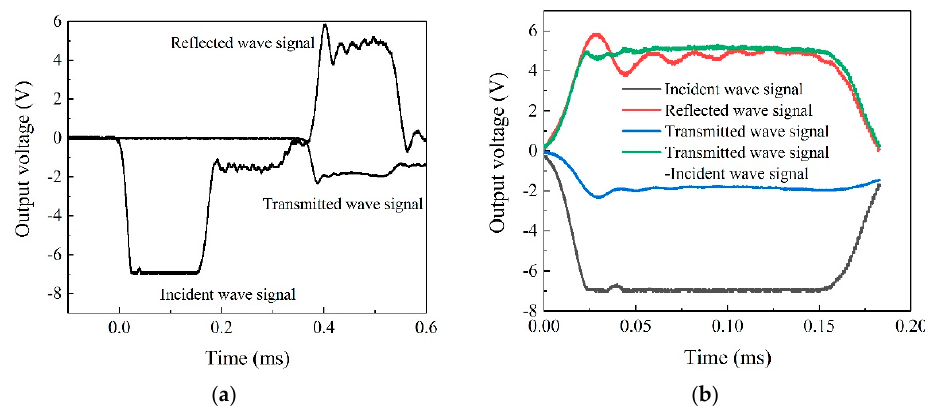
Figure 6. ( a ) The original wave signals from the SHPB test, and ( b ) their relationship.